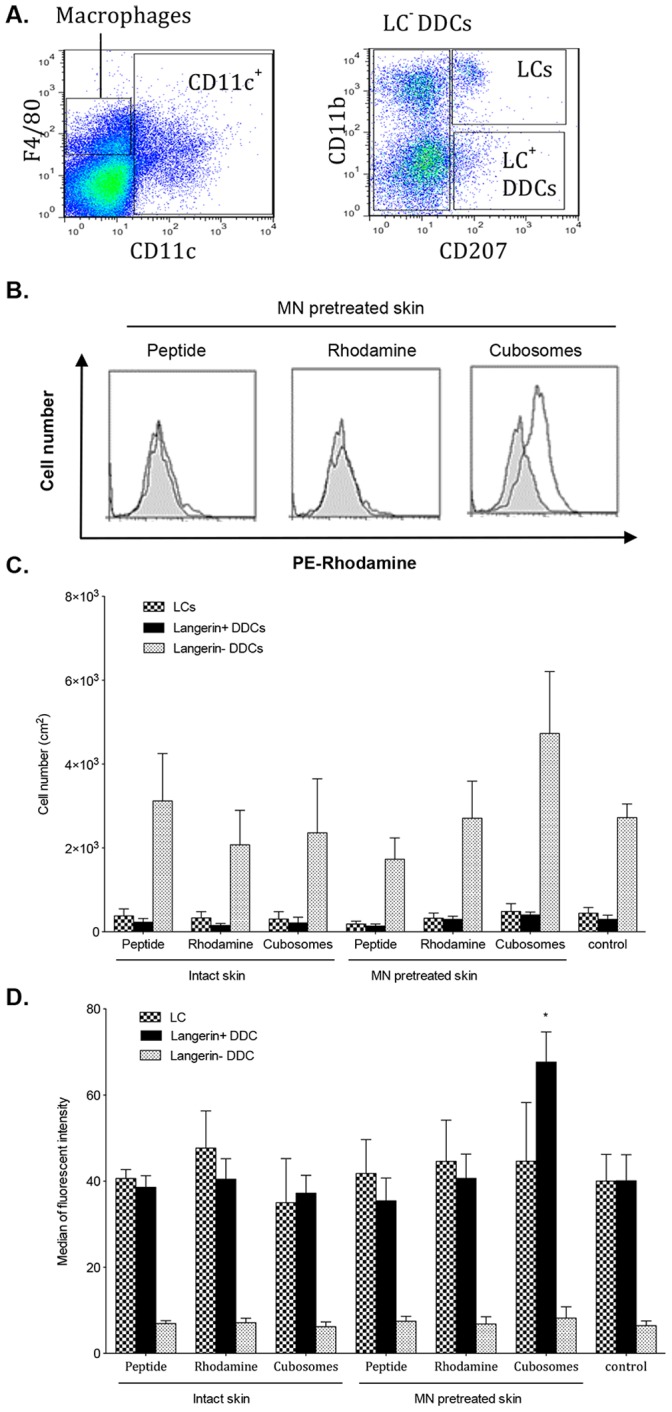
Antigen uptake by skin APC.(A) Representative dot plots showing gating for flow cytometric analysis. CD11chi DC cells were selected and further gates determined on the basis of CD207 and CD11b expression. (B) Representative histograms of the uptake of vaccine; TMR-SIINFEKL (peptide), rhodamine-labeled cubosomes (Rhodamine) or TMR peptide-loaded cubosomes (cubosomes) by Langerin+ DDC following TCI. The solid grey histograms are Langerin+ DDC from unimmunised controls and the open histograms are Langerin+ DDC from immunised mice. (C) Number of LC, Langerin+ DDC and Langerin− DDC at 240 min in untreated control mice (control) or in mice immunised with aqueous TMR-SIINFEKL (peptide), rhodamine-labeled cubosomes (rhodamine) and TMR-SIINFEKL-loaded cubosomes (cubosomes) in the presence and absence of MN pretreatment. (D) Uptake of antigen (median fluorescence intensity) by LC, Langerin+ DDC and Langerin− DDC at 240 min in untreated control mice (control) or in mice immunised with aqueous TMR-SIINFEKL (peptide), rhodamine-labeled cubosomes (rhodamine) and TMR-SIINFEKL-loaded cubosomes (cubosomes) in the presence and absence of MN pretreatment. The results of the antigen uptake are given as. Data are mean+SEM and are representative of three independent experiments with 5 mice per group. *P<0.05 (two-tailed unpaired Student’s t-test).